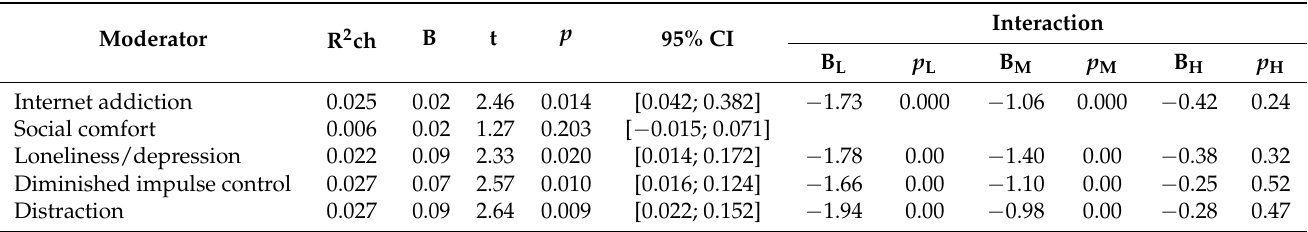
Table 2. Results of moderation analysis for the independent variable—cyberhate severity—and dependent variable—decisional forgiveness.